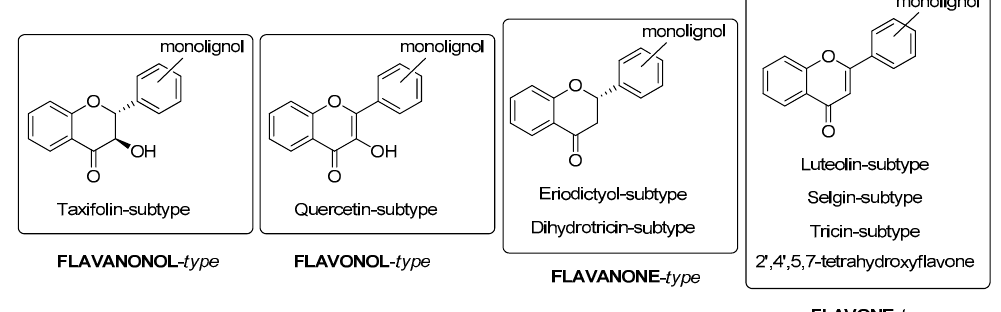
Figure 1. Classification of naturally occurring flavonolignans.